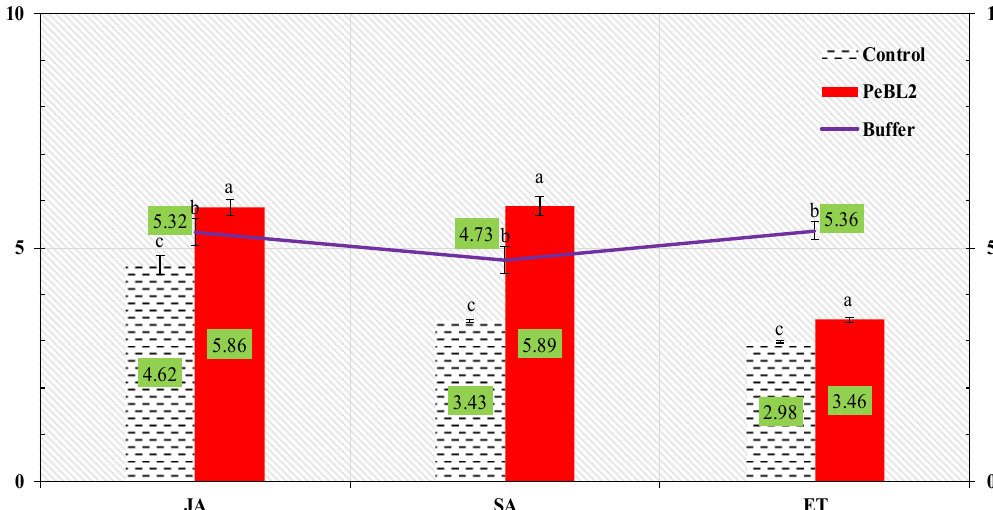
Figure 7. JA, SA, and ET contents in O. sativa seedlings (mean ± SD). PeBL2-treated tests were gathered 1 d after the spraying. Cnaphalocrocis exigua were inoculated on seedlings 1 d after they were sprayed with treatment, and samples were collected 1 d after they were inoculated: (a–c) are significant differences among treatments and control. Data were compared statistically. The LSD, ANOVA, and Levene’s test were employed by Statistix version 8.1. ( p = 0.05). 2.6. Relative Fold Changes in the Expressions of Defense-Related Genes PeBL2 increased the defense response in O. sativa seedlings. All test genes were upregulated by PeBL2 treatment, showing transcripts statistically more expressed than in the control. It was considered that induced resistance was caused by the aphid infestation and enhanced by PeBL2. Although genes involved in the JA pathway were moderately expressed, all JA-associated genes were upregulated after 24, 48, 72, and 96 h of C. exigua infestation (Figure 8A). Similar trends were observed for all SA- and ET-associated genes that were significantly upregulated and significantly different from control samples for all observation times (Figure 8B,C). This suggests that resistance against C. exigua was due to increased transcription of the JA, SA, and ET genes.